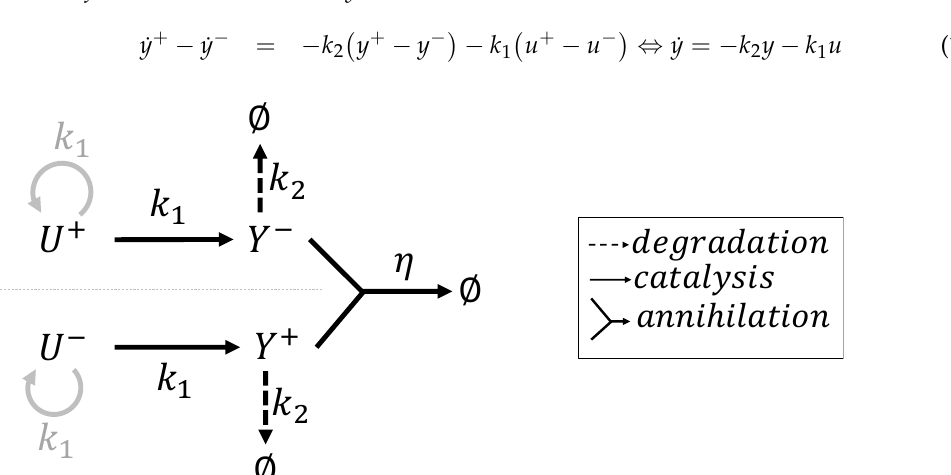
Figure 1. The first-order transfer function described in Example 2 depicted as a network with the dual-rail representation. Here, we have the duplication of unimolecular reactions of degradation and catalysis. In the subsequent graphs, the autocatalysis represented in grey will be omitted. Through a bimolecular reaction, the two components of the output signal y = y + − y − annihilate each other.